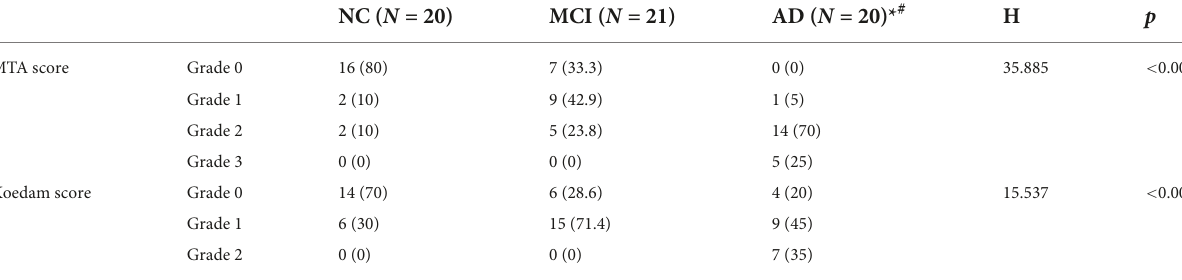
TABLE 5 Evaluation of hippocampal atrophy and parietal lobe atrophy [n (%)].